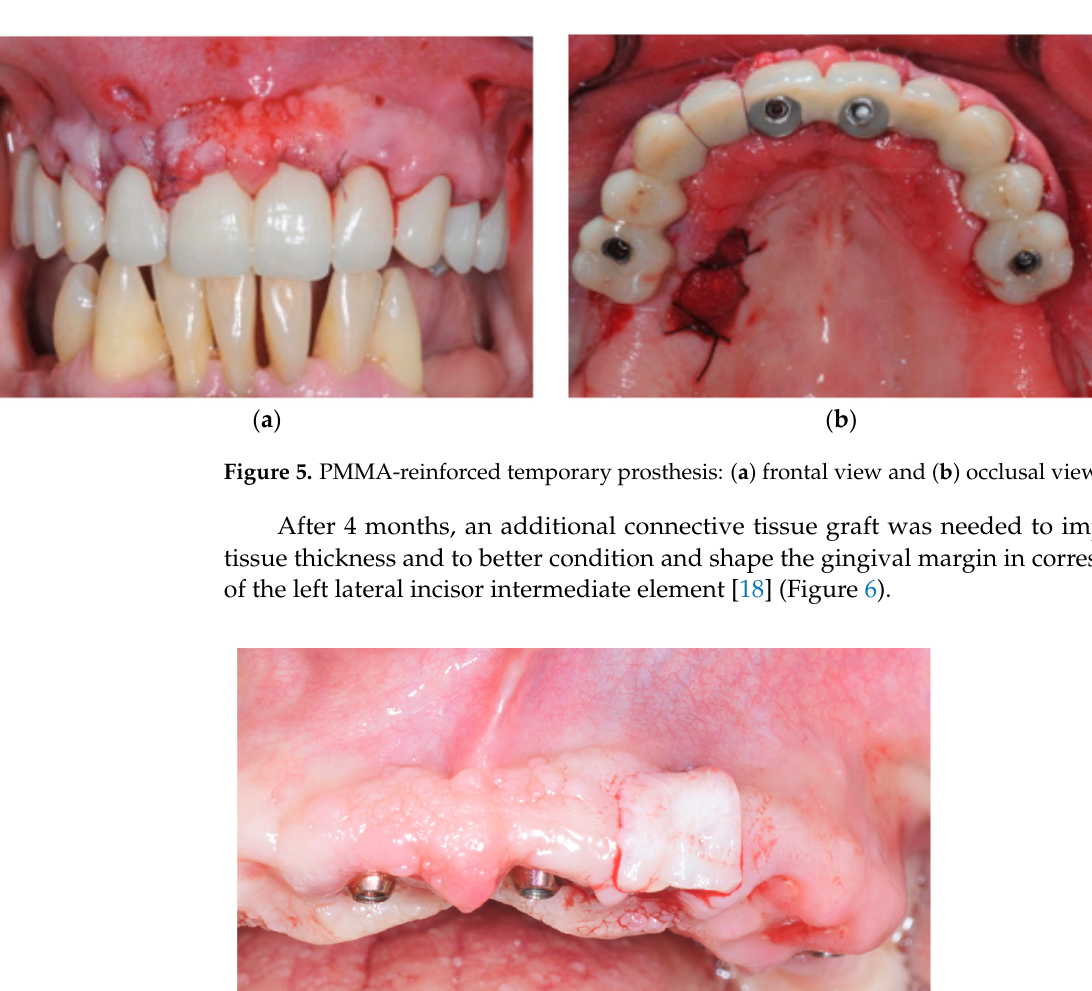
Figure 8. Soft tissue occlusal view after 6 months of provisional conditioning. A virtual occlusal registration was acquired through an optical scan of the buccal surfaces of the mandibular and maxillary arches in contact, so as to maintain the pre-ex- isting vertical dimension. The extended scans of the soft tissues registered in all optical acquisitions, including the vestibule, the keratinized mucosa, the palatal rugae and the incisal papilla, were used to superimpose the consecutive digital impressions. As a consequence, the maxillary and mandibular arches were positioned in the virtual articulator respecting the correct inter- maxillary relation. The accuracy of the digital position of the implants was verified clinically and radio- graphically with the aid of an aluminum prototype designed in the virtual environment. The fit was assessed on the prototype, clinically by visual inspection, finger pressure with Sheffield test and by using peri-apical radiographs. A zirconia monolithic (Xanos Evo Blank, Dentag Italia SRL, Terlano, Italy) full arch prosthesis assembled with a model-free digital workflow was finally cemented to the titanium framework (Figures 9 and 10). The fixed implant-supported prosthesis was screwed to the implants at 30 Ncm ac- cording to the manufacturer’s instructions. Clinical and radiographic examinations were performed to assess the fit and precision of the final framework, and only minor occlusal adjustments were made (Figures 9 and 10).